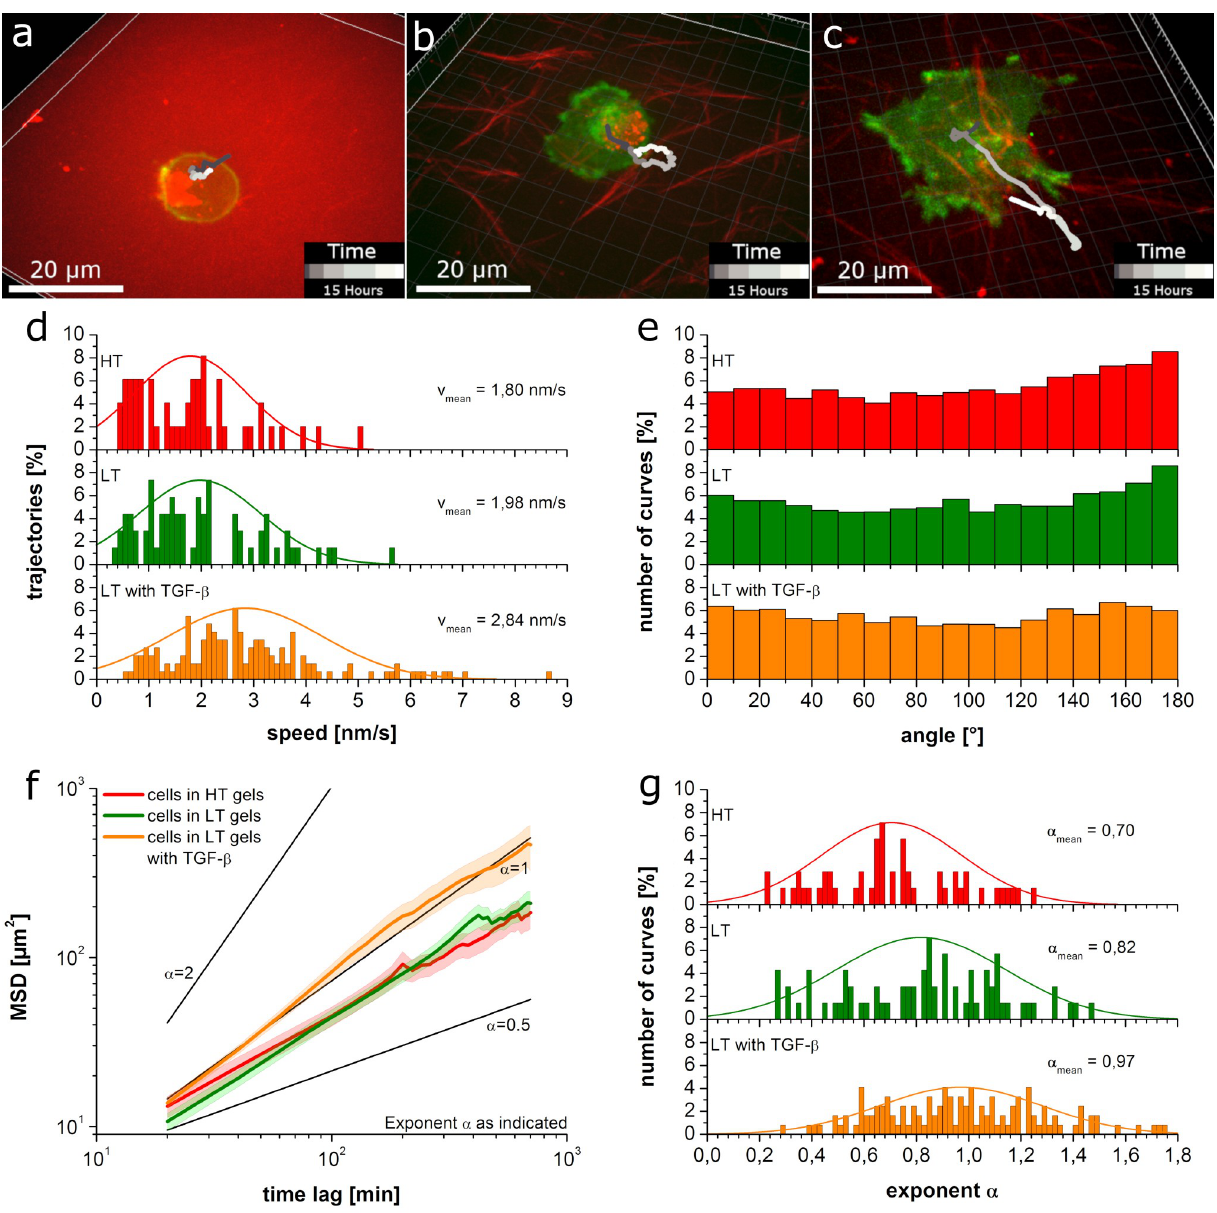
Fig 2. MDA-MB-231 migration in collagen gels. a)-c) representative images of cells (green) and their migratory tracks (gray shades) in HT gels (a), LT gels (b) and LT gels in presence of TGF- β (c) respectively (collagen fibers in red); images represent 3D xyz-stacks at the first measured time point and trajectories (in gray shades) represent the 3D path over time with a time scale as indicated in the color bar in the lower right corners; d) histogram of speed distributions show the increase in speed upon addition of TGF- β ; e) angle distribution between different steps shows significant backtracking due to confinement for HT and LT gels (HT compared to LT: p < 0.005, HT compared to LT with TGF- β : p < 0.001, LT compared to LT with TGF- β : p < 0.001); f) average mean square displacements for the different conditions show subdiffusive behavior in the absence of TGF- β ; g) histogram of exponent α values show the increase of α upon addition of TGF- β